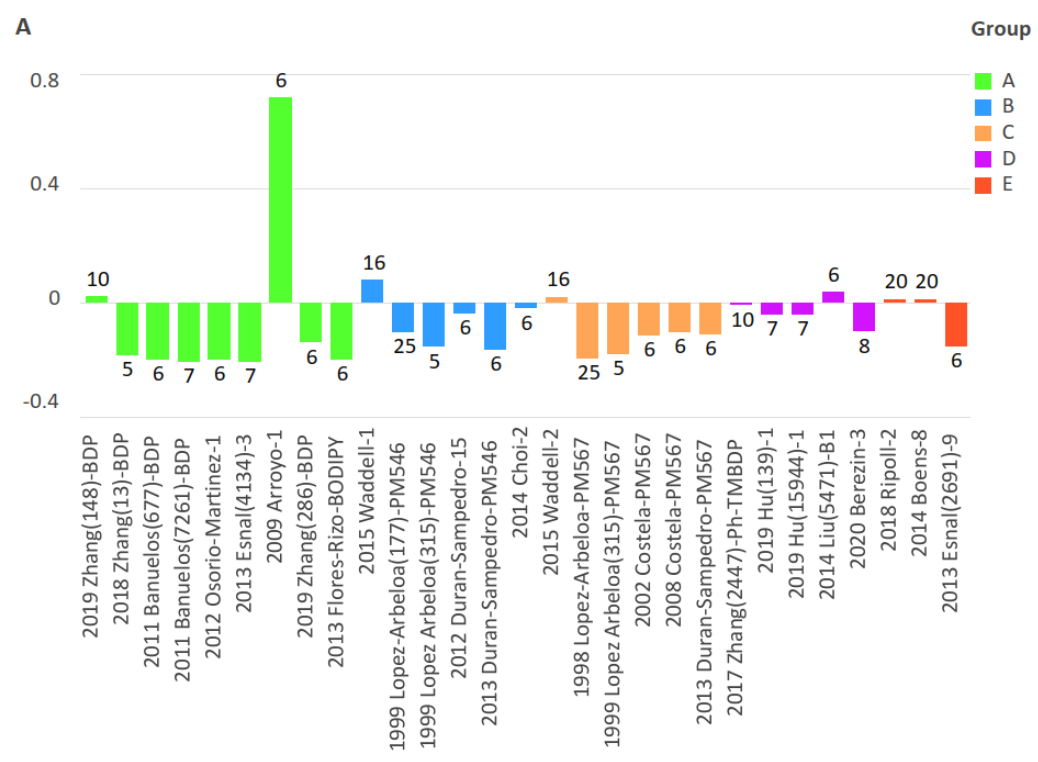
Figure 11. Solvatochromic sensitivity parameter A for the duplicates of the studied dataset, solvent count ≥ 10 for a target dataset, and solvent count ≤ 9 for an extra dataset.